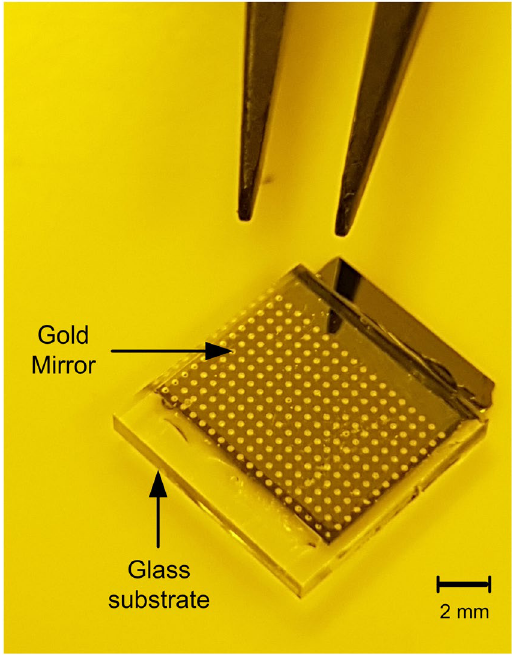
Figure 1. Photo of a fabricated optrode sensor array prototype, with 13 × 18 vias with centre-centre spacing of 500 μ m × 500 μ m. The gold mirrors ( φ = 250 μ m) covering the liquid crystal side of the vias ( φ = 60 μ m) are visible through the glass substrate, and transparent ITO and liquid crystal layers. In practice, the device will be positioned such that the glass substrate will be at the bottom and vias facing upwards in contact with the biological sample (upside down relative to this view). The overall size of this prototype is 10 mm × 11.5